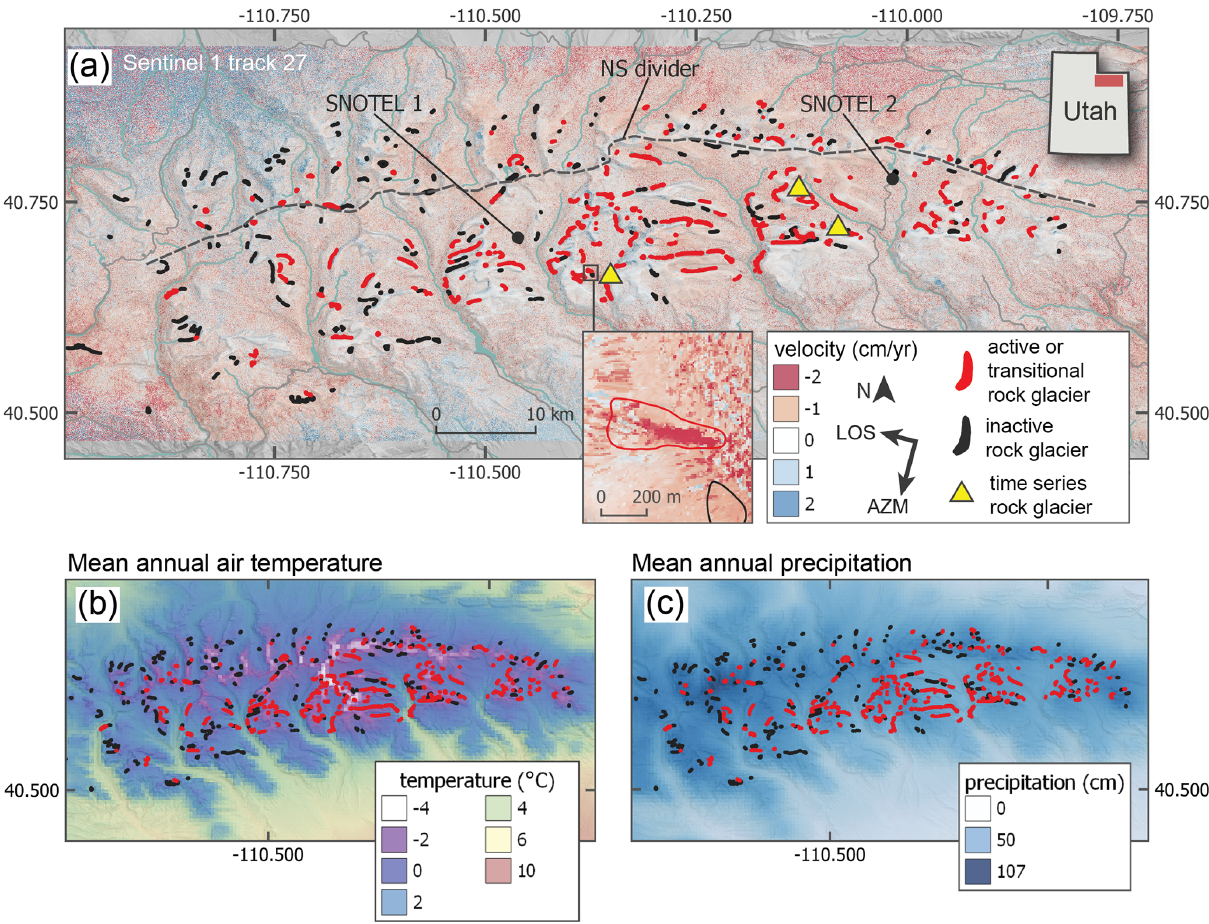
Figure 2. Uinta study site. (a) Hillshade map of the Uinta Mountains overlaid with average 1-year InSAR velocity map derived from descending track 27. Red polygons represent active rock glaciers identified in this study. Black polygons represent rock glaciers identified in the previous inventory (Munroe, 2018) which are inactive (i.e., show no coherent and distinct deformation) in our InSAR velocity maps. Rock glacier size is exaggerated for plotting. SNOTEL 1 is the Five Points Lake station. SNOTEL 2 is the Chepeta station. The dashed black line separates the “North Uintas” from the “South Uintas”. Yellow triangles represent the three rock glaciers used in time series analysis, which are, from left to right, the Grayling Lake, Whiterocks River, and Rockflour Lake rock glaciers. Data from USGS, NRCS, and Natural Earth. (b) Mean annual air temperature of the Uinta Mountains. (c) Mean annual precipitation in the Uinta Mountains. In (b) and (c) , data are derived from PRISM 30-year normals